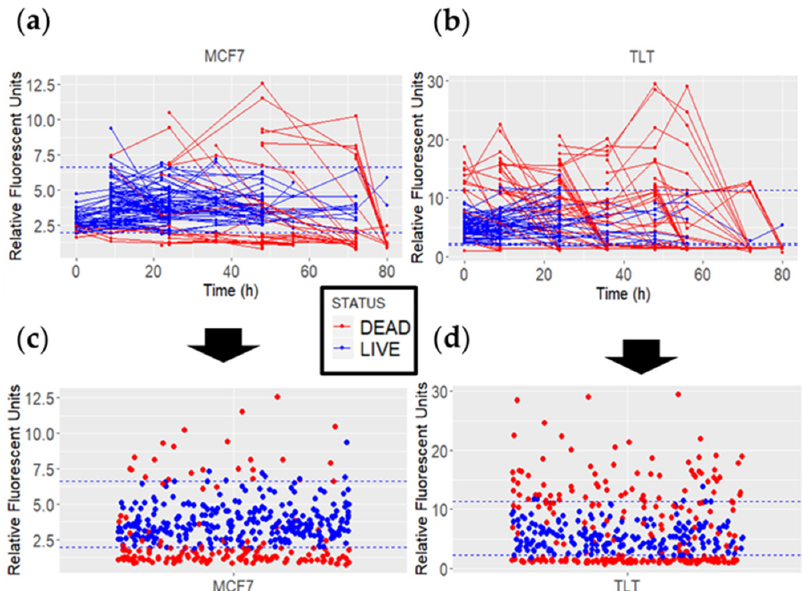
Figure 7. MCF7 and TLT FV fluorescence intensity values of dead (red) and viable (blue) cells over 80 h. The dashed blue line represents the viable FV intensity range. ( a , b ) The lines connect the FV intensity values of each cell over time. ( c , d ) All measured data points for each cell line are plotted as individual points.